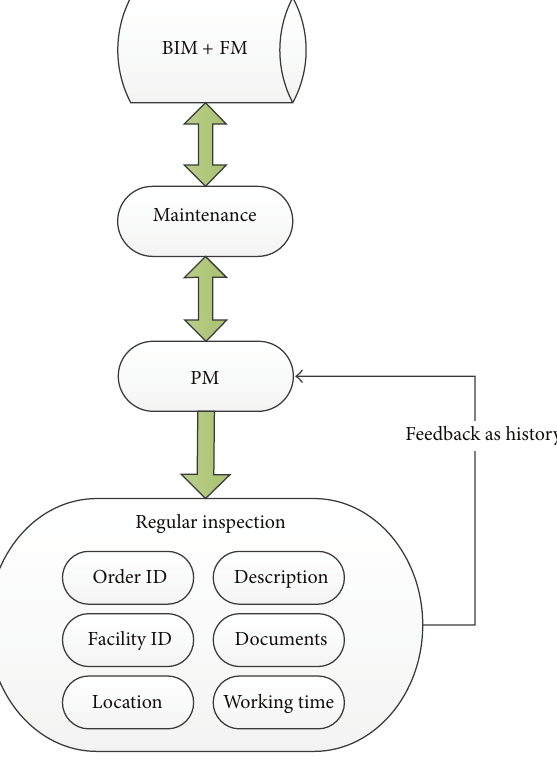
Figure 4: BIM-based PM